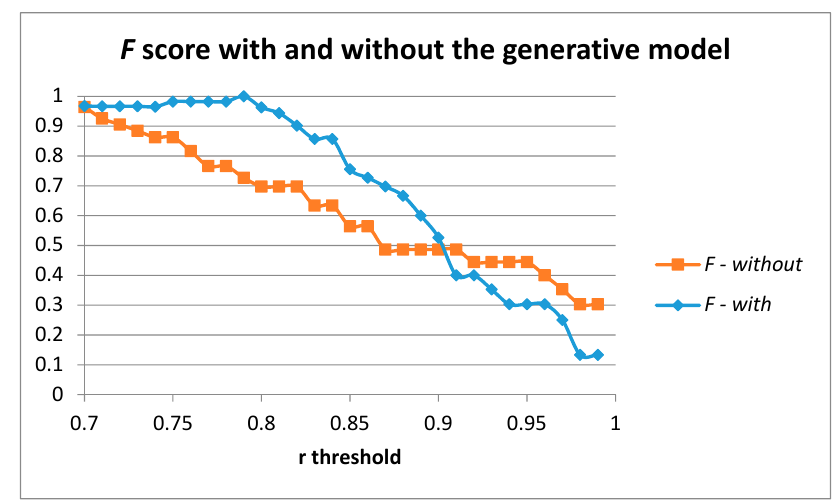
Figure 8. Results using the generative model compared to those achieved without the generative model for one layer of 100 hidden units in the auto-encoder.